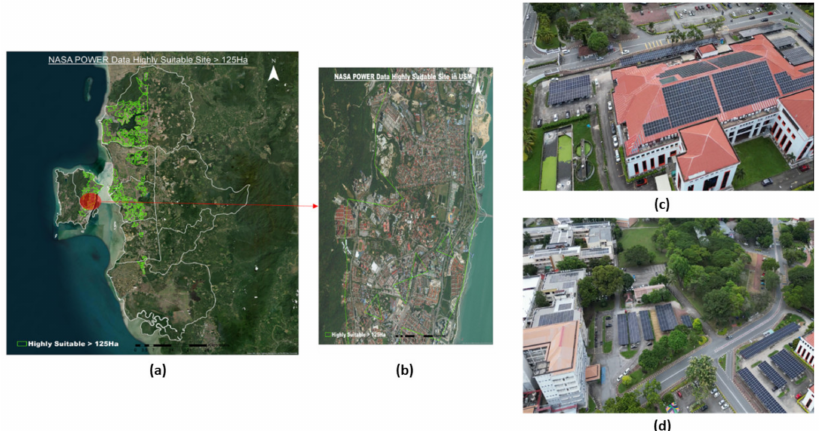
Figure 11. ( a ) The highly suitable site with a size greater than 125 Ha, ( b ) the highly suitable site located in the USM, ( c ) rooftop solar panels installed in the USM, ( d ) solar carports installed in the